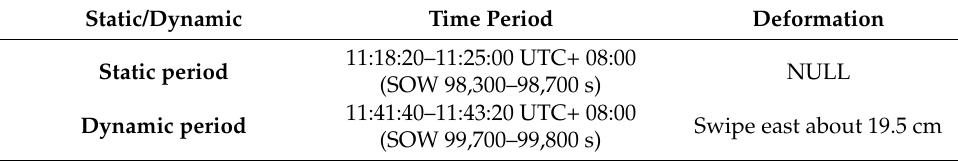
Table 3. The record of the simulated deformation in Scene 1.